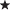
Deletion of htsA induced higher neutrophil recruitment at skin infection sites of mice. Groups of mice were subcutaneously injected with wild type, ΔhtsA, or ΔhtsA-htsA strains at a dose of ∼2.0 × 108 CFU, and the skin containing the infection area was excised and homogenized at 24 h postinfection. (A) MPO activity at skin infection sites of mice. The MPO activity (U/total) of mice infected with ΔhtsA was higher than that of mice infected with wild type or ΔhtsA-htsA. (B) The total bacterial CFU at skin infection sites of mice. There were no statistically significant differences in total bacterial CFU among the three GAS strains. (C) Microscopic pictures of Gram staining at a skin infection site. inflammatory cells, bacteria. ∗∗P < 0.01.